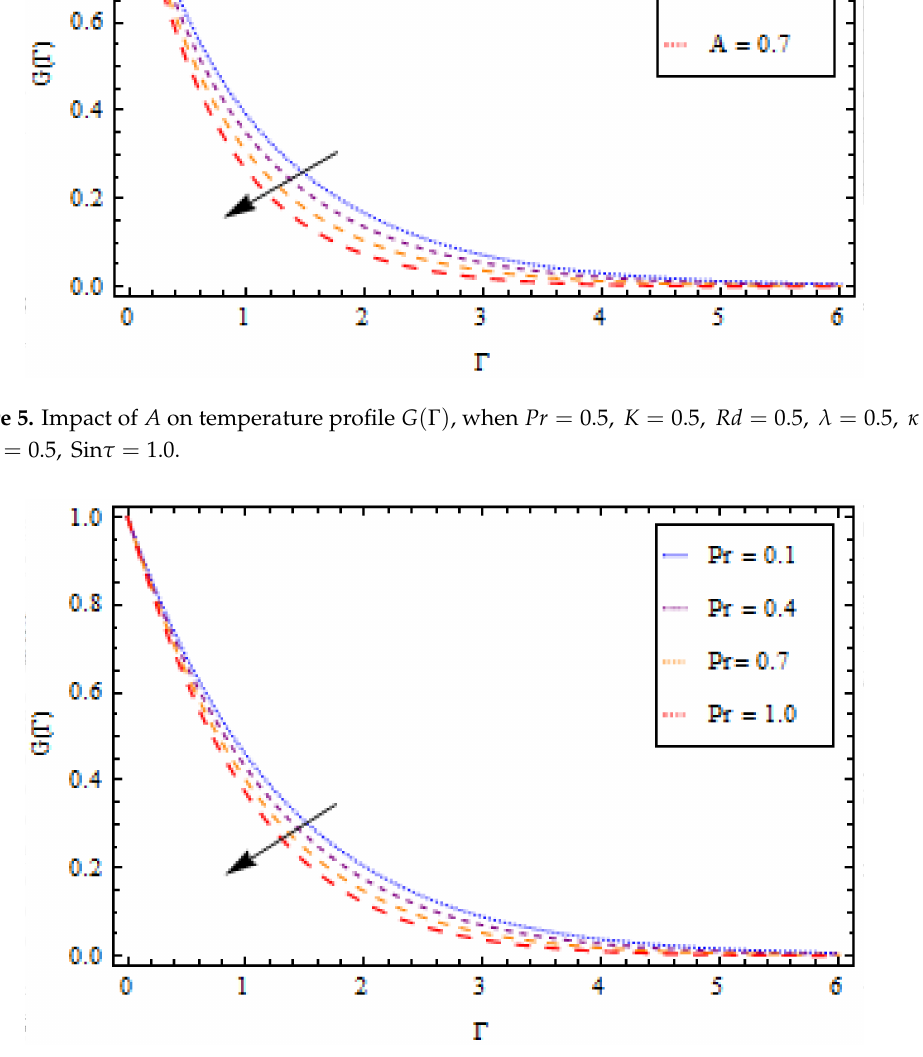
Figure 6. Impact of Pr on temperature profile G ( Γ ) , when A = 0.5, K = 0.5, Rd = 0.5, λ = 0.5, κ = 0.5, γ = 0.5, Sin τ =